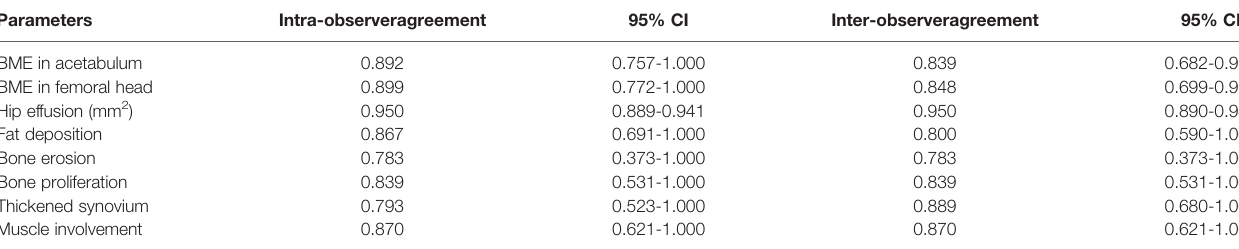
TABLE 2 | Intra and inter-observer agreement for MRI assessments of two radiologists. Parameters